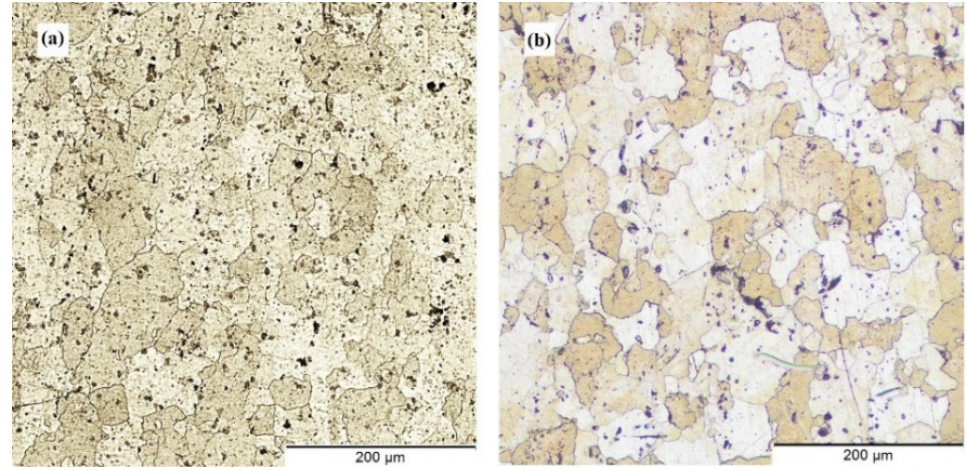
Figure 7. Microstructure of the base metals ( a ) AA6061-T6 and ( b ) AA7075-T6. The FSAM build is cross-sectioned from different areas to view the progression of the microstructure as shown in Figure 8. Following this, optical microscopy is utilized to scrutinize the microstructures of the sectioned areas at the various points as indicated in Figure 8. From the microstructure images (Figure 9a–i), it can be evidently seen that there are no defects such as micropores or voids in any of the areas. It is essential to take notice that none of the layers exhibited any volumetric faults that might be harmful to the mechanical characteristics. It can be particularly highlighted that no wormhole flaws